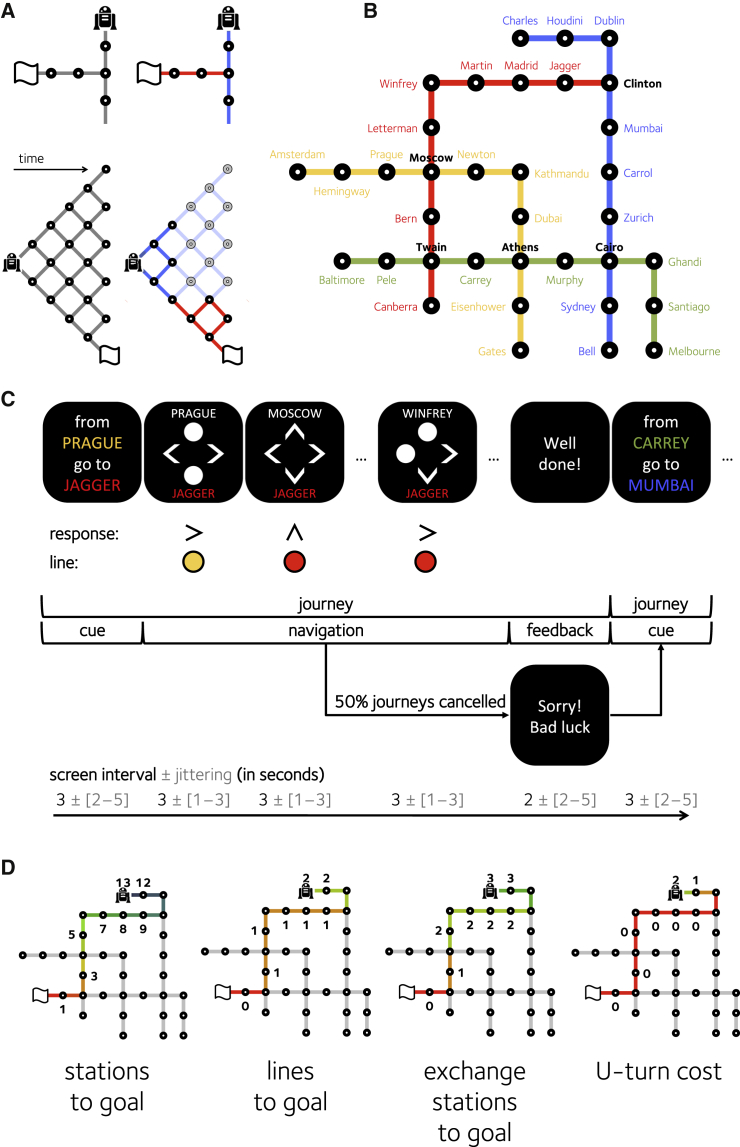
Task and Design(A) Schematic representation of planning under a flat (left) and hierarchical (right) policy. Each node from left (start state, shown by the robot) to right shows a possible state (i.e., station) that could be visited. The flag indicates the destination station. A hierarchical policy allows the agent to “chunk” the maze into contexts (here, a red line and a blue line). This in turn reduces the cost of planning and plan representation.(B) The subway map that participants navigated. The map was rotated and the line colors and station names were shuffled between participants. Participants only saw the map during training.(C) A schematic depiction of the sequence of events (trials) that occurred on an example journey. The names at the top and bottom of the screen refer to the current and destination stations, respectively. The responses (arrows) and lines (colored dots) were not shown to participants. Timings (in seconds) for the various events are shown below.(D) Examples of how the various distances were calculated for an example map: DS (stations to goal), DL (lines to goal), DX (exchange stations to goal), and DU (U-turn cost). The numbers and blue-red colormap show the distance in each metric that was used to estimate the cost of planning. The robot shows the start point, and the flag shows the destination station.